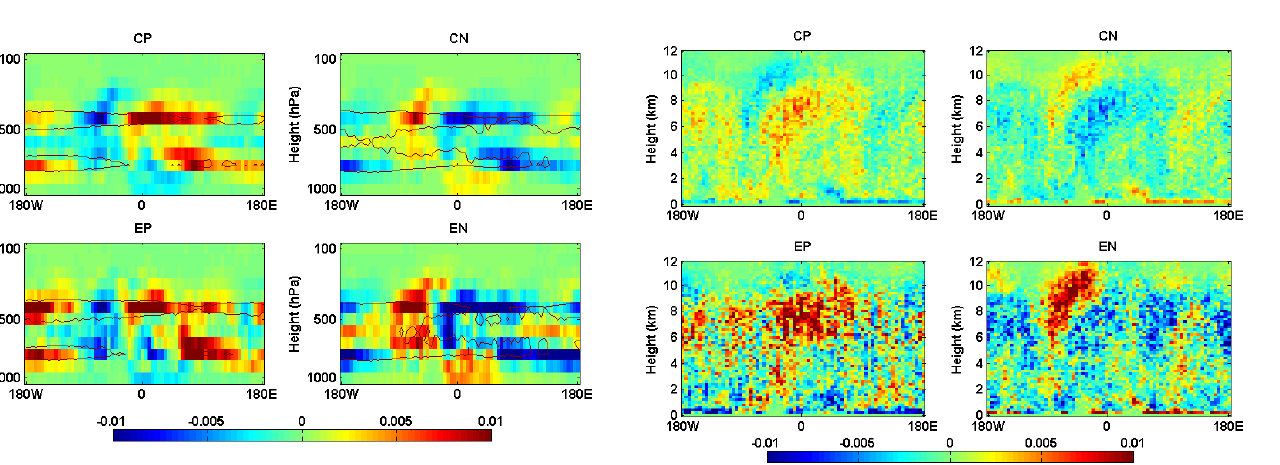
Fig. 5. Same as Fig. 4, but for clouds derived using CALIPSO Fig. 5: Same as Fig. 4, but for clouds derived using CALIPSO data.